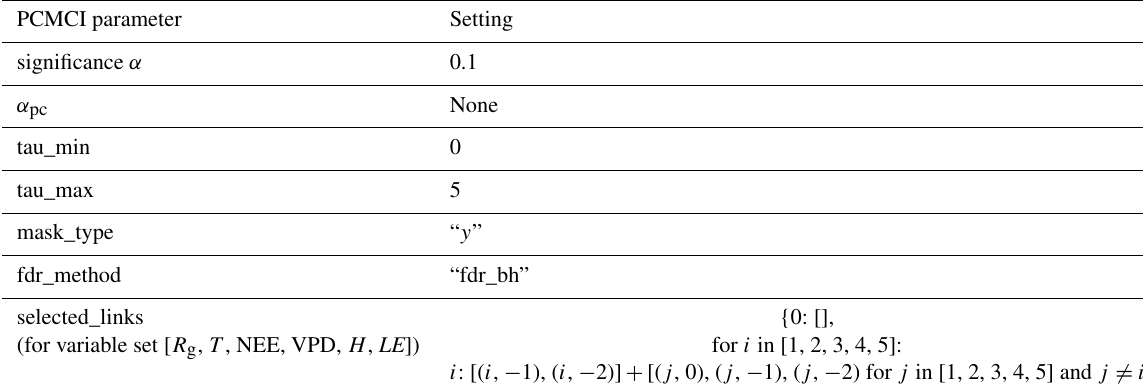
Table A2. PCMCI parameters that were used differently from default settings. PCMCI parameter Setting significance α